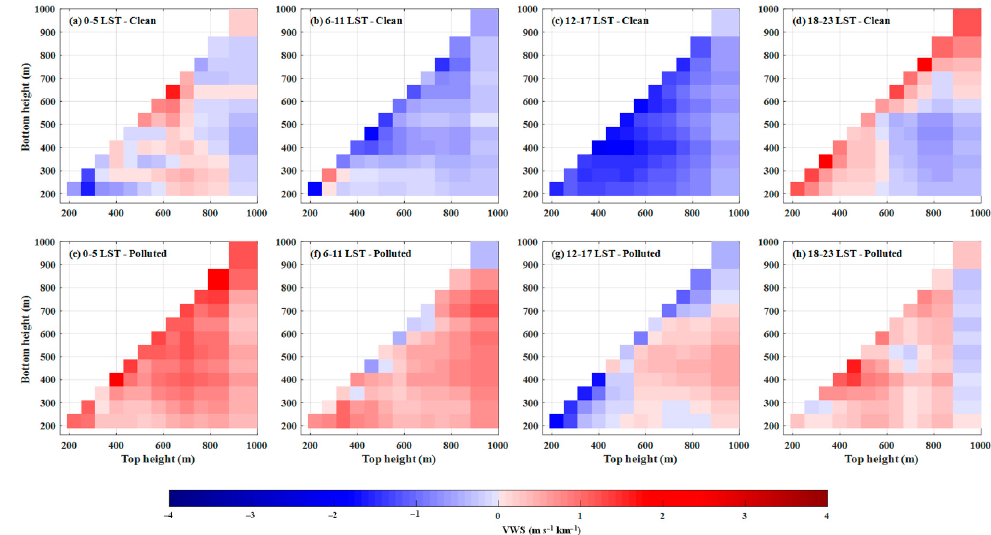
Figure 8. Anomalies of 6 hourly averaged VWS computed between different heights relative to averages of winters from 2016–2020 under ( a – d ) clean and ( e – h ) polluted conditions in JM for ( a , e )